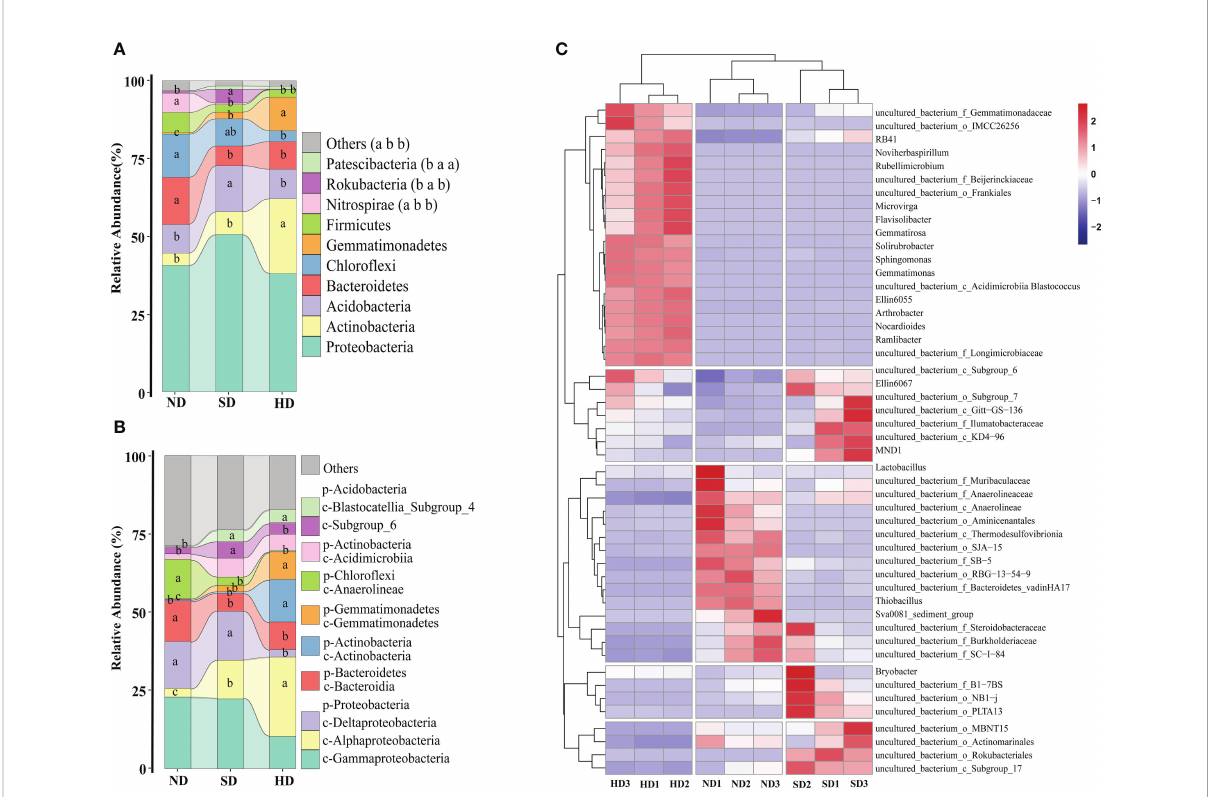
FIGURE 4 Bacterial community composition of the non-degraded (ND), slightly degraded (SD), and heavily degraded (HD) alpine wetland areas. Mean ±standard error (n = 3). (A) Bacterial phyla (p), (B) classes (c), (C) classi fi ed genera (top 50). In the stacked diagram, the same lowercase letters indicate no signi fi cant